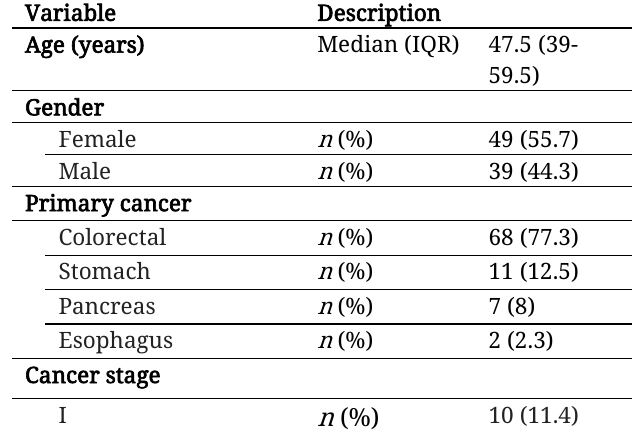
Table 1: Patients’ characteristics